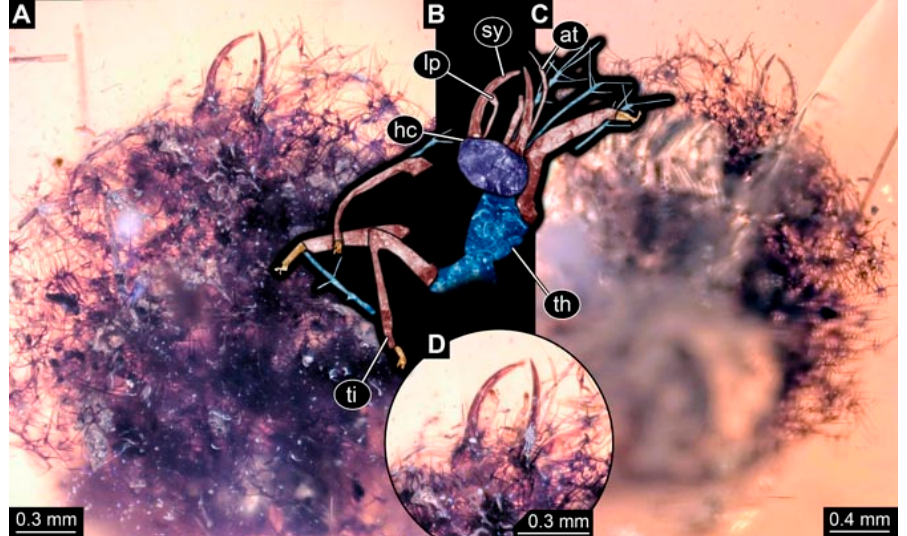
Figure 47. Specimen 4877 (Weiterschan BuB 31); Myanmar amber. ( A ) Dorsal view. ( B ) Dorsal view, colour-marked. ( C ) Ventral view. ( D ) Close-up of head capsule in dorsal view. Abbreviations: at = antenna; hc = head capsule; lp = labial palp; sy = stylet; th = thorax; ti = tibia. (59) Specimen 4703 (SMF Be 2021) is preserved in Baltic amber. It is accessible in a